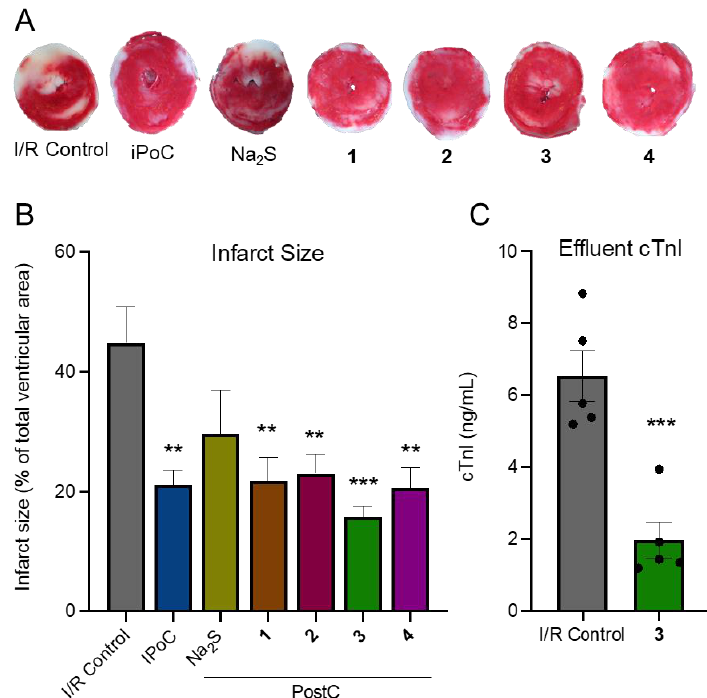
Figure 3. RSS reduce myocardial infarct size and pathological damage in isolated mice hearts sub- jected to I/R injury. ( A ) Representative images of TTC-stained transverse cardiac slices. ( B ) Quanti- tative graph of myocardial infarct size. The data represent the mean ± SEM (n = 8). ( C ) RSSH donor 3 reduces troponin-I level during reperfusion injury (n = 5). ** p , 0.005, *** p , 0.001 vs. I/R-Control.